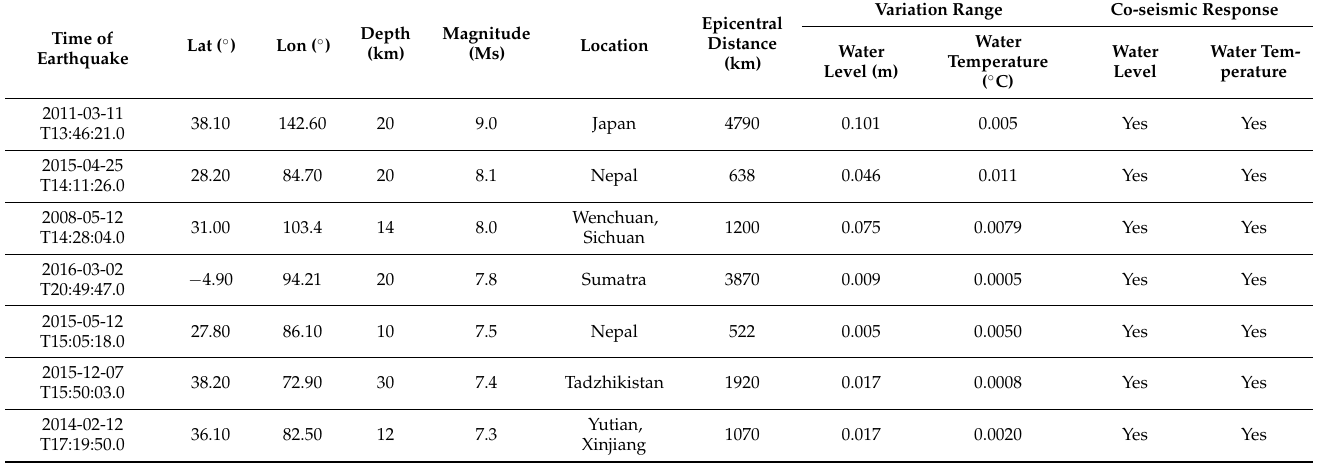
Table 2. Statistical table of the responses of the digitized water level and water temperature to large earthquakes in the Lhasa geomagnetic platform well.